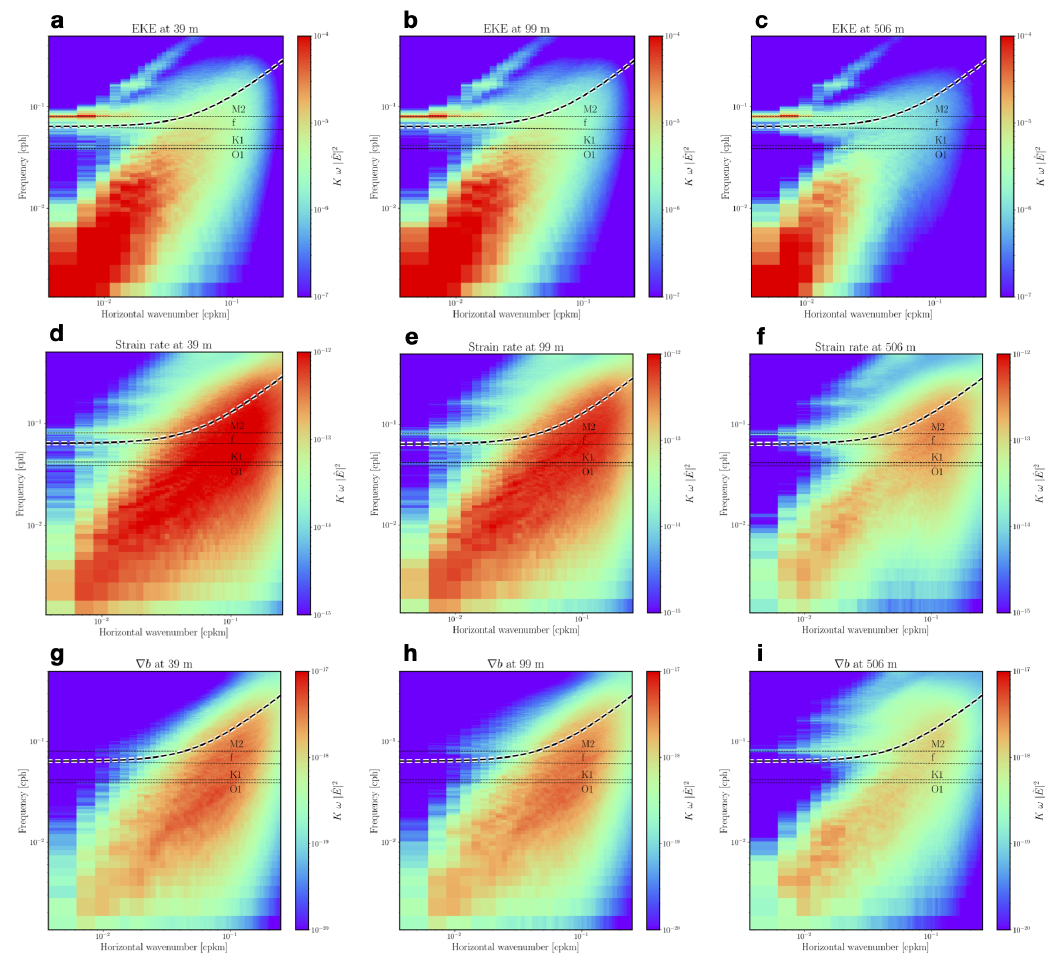
Figure A2. Frequency-wavenumber spectra computed from October 27 to December 27, 2011 of ( a ) KE at 39 m, ( b ) KE at 99 m, ( c ) KE at 506 m, ( d ) Strain rate at 39 m, ( e ) Strain rate at 99 m, ( f ) Strain rate at 506 m, ( g ) |∇ b | at 39 m, ( h ) |∇ b | at 99 m, ( i ) |∇ b | at 506 m. The dashed line corresponds to the dispersion relation curve (associated with linear internal gravity waves, IGWs) that corresponds to the highest baroclinic mode resolved by the simulation. This curve allows for the partition between balanced motions (below the curve) and IGWs (above the curve). These spectra are presented in a variance preserving form, which allows the direct comparison of the relative contribution of different time and spatial scales to the total